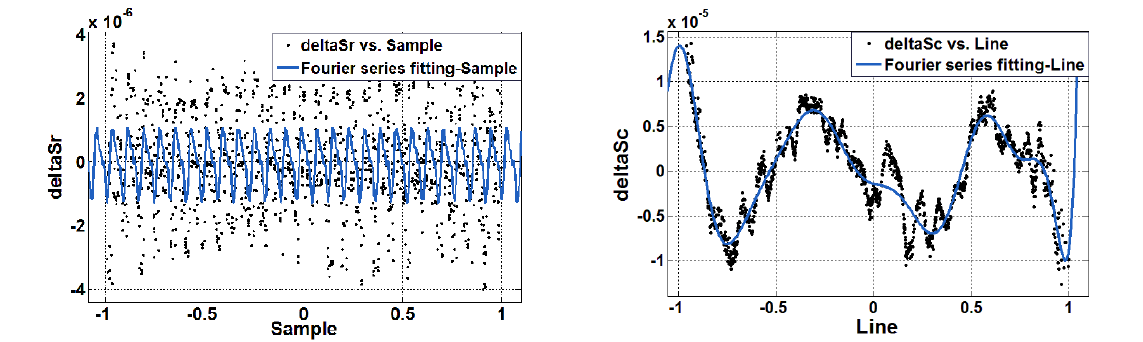
Figure 6. Fourier series fitting and residues in along-track Figure 5. Fourier series fitting and residues in cross-track direction direction Table 2. Accuracy of RFM computation